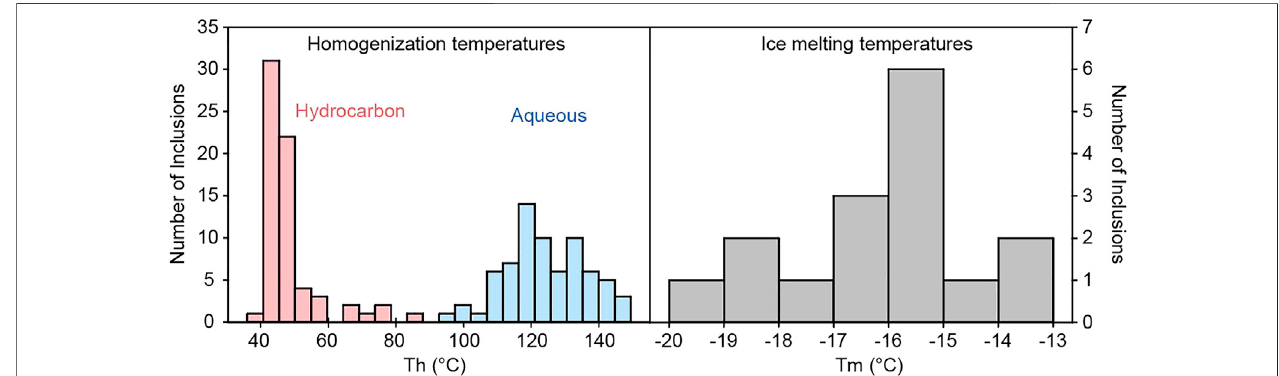
FIGURE6| Histogramofhomogenizationtemperature measurementsforaqueous(blue)andhydrocarbon-bearing(red) fl uidinclusions.Illustrateslargedifference in the homogenization temperature between aqueous and hydrocarbon-bearing fl uid inclusions and bimodal distribution of aqueous fl uid inclusions.